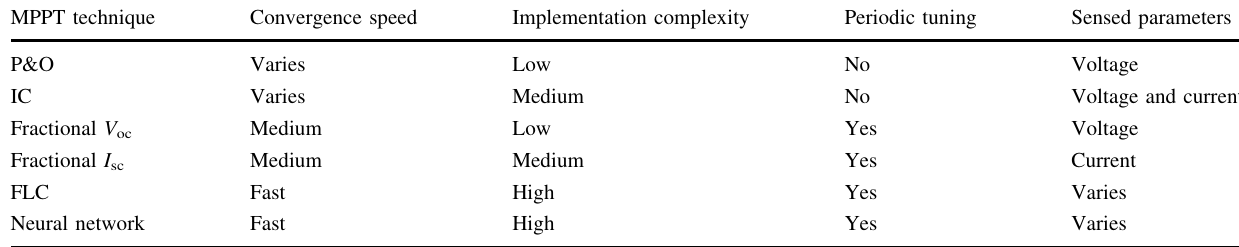
Table 7 Comparison of MPPT algorithms used in HEVs MPPT